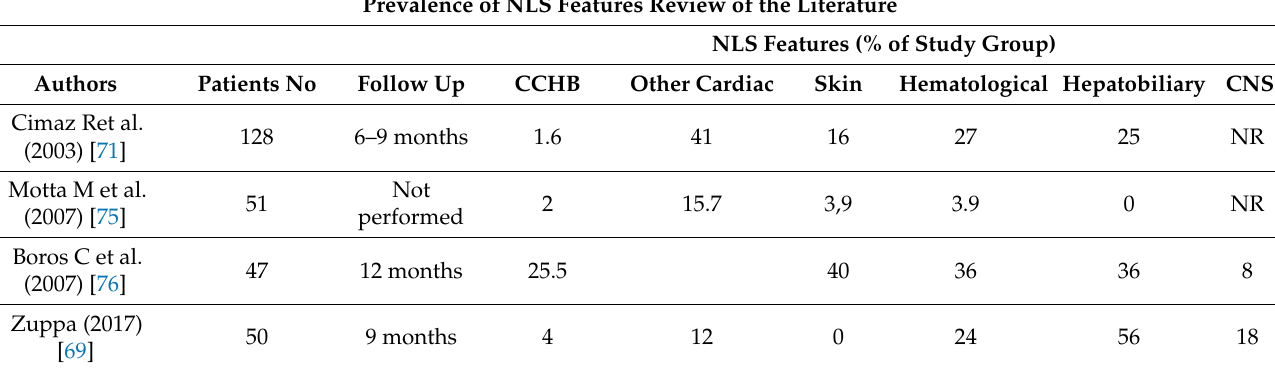
Table 3. Prevalence of neonatal lupus symptoms. Prevalence of NLS Features Review of the Literature NLS Features (% of Study